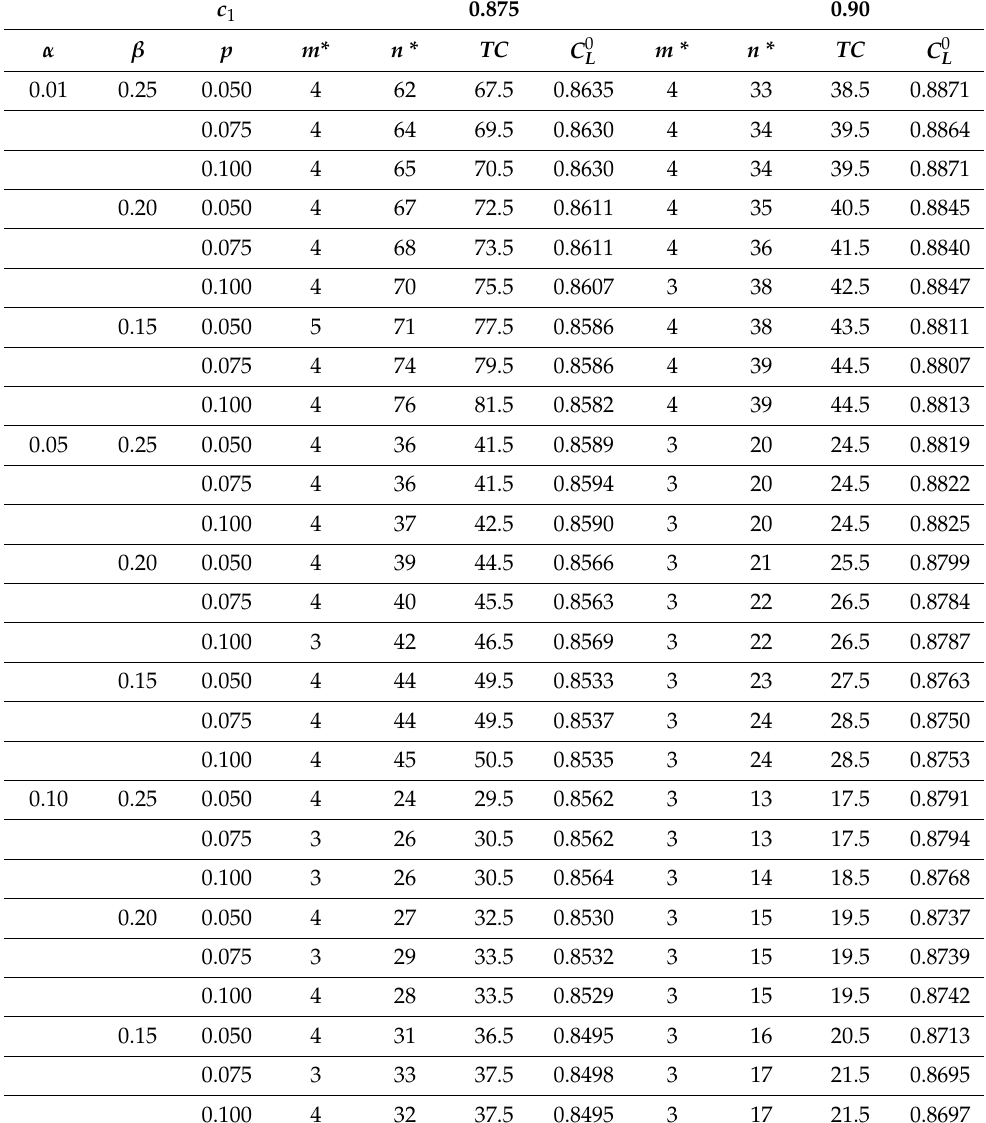
for c 1 = 0.875, 0.90 and L